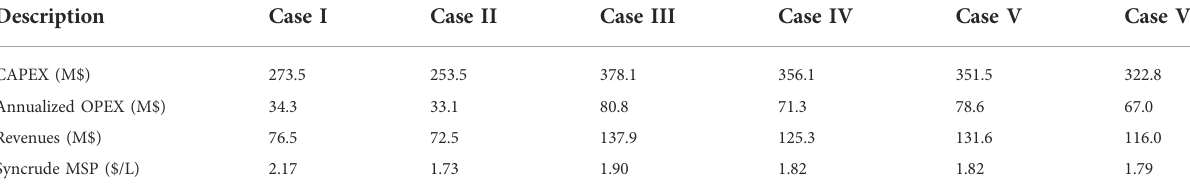
TABLE 6 Summary of economic analysis for different